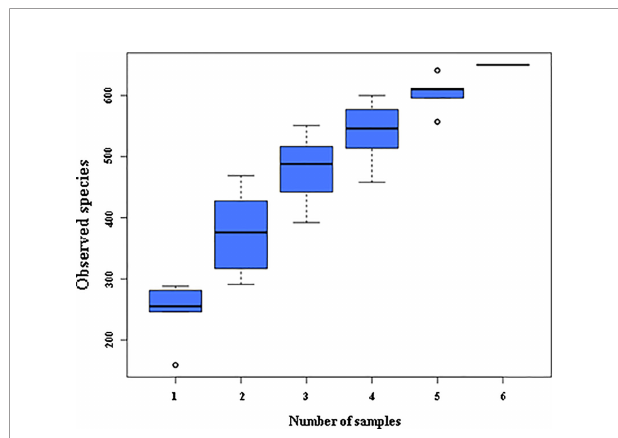
FIGURE 1 | Species accumulation box plot. The abscissa is the sample size; The y-coordinate is the number of OTU after sampling.